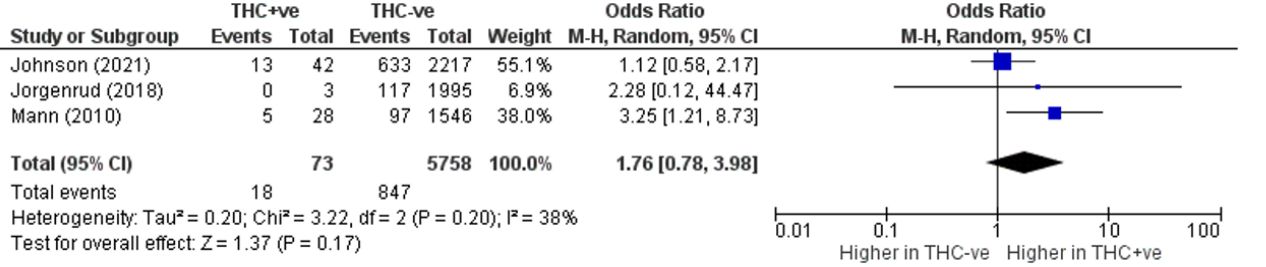
Figure 3. Sensitivity analysis with pooled odds ratio (95% CI) of motor vehicle collision (MVC) risk associated with THC exposure after removing Kalantari Meibodi et al. [31 – 33].